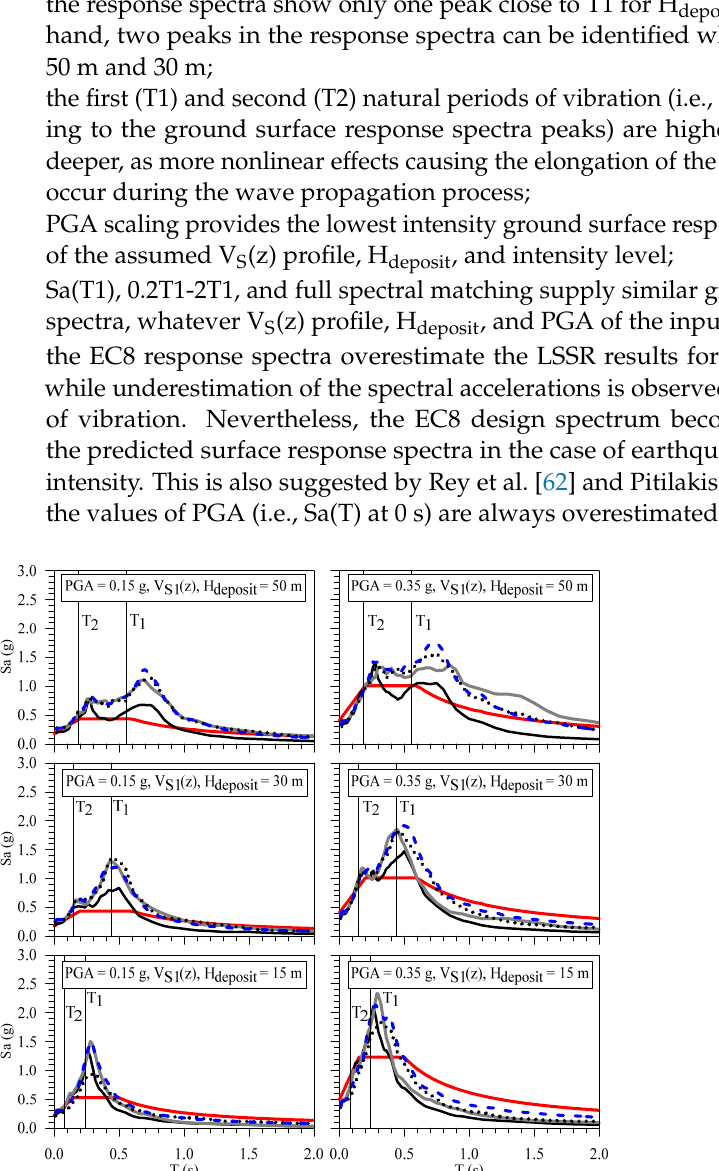
EC8 PGA scaling fake Sa(T1) scaling Figure 5. Mean response spectra of the ground surface motions obtained by means of LSSR analyses considering the V S1 (z) profile, 4 different selection strategies, and PGA equal to 0.15 g and 0.35 g. The EC8 response spectra going from the first to the bottom line refer to ground type C, C, and E, respectively.